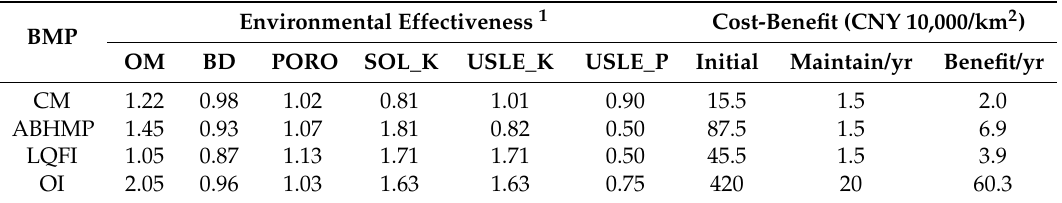
Table 2. Environmental effectiveness and cost-benefit knowledge of the four BMPs (CM = Closing measures, ABHMP = Arbor–bush–herb mixed plantation, LQFI = Low-quality forest improvement, OI = Orchard improvement) (adapted from [2]).